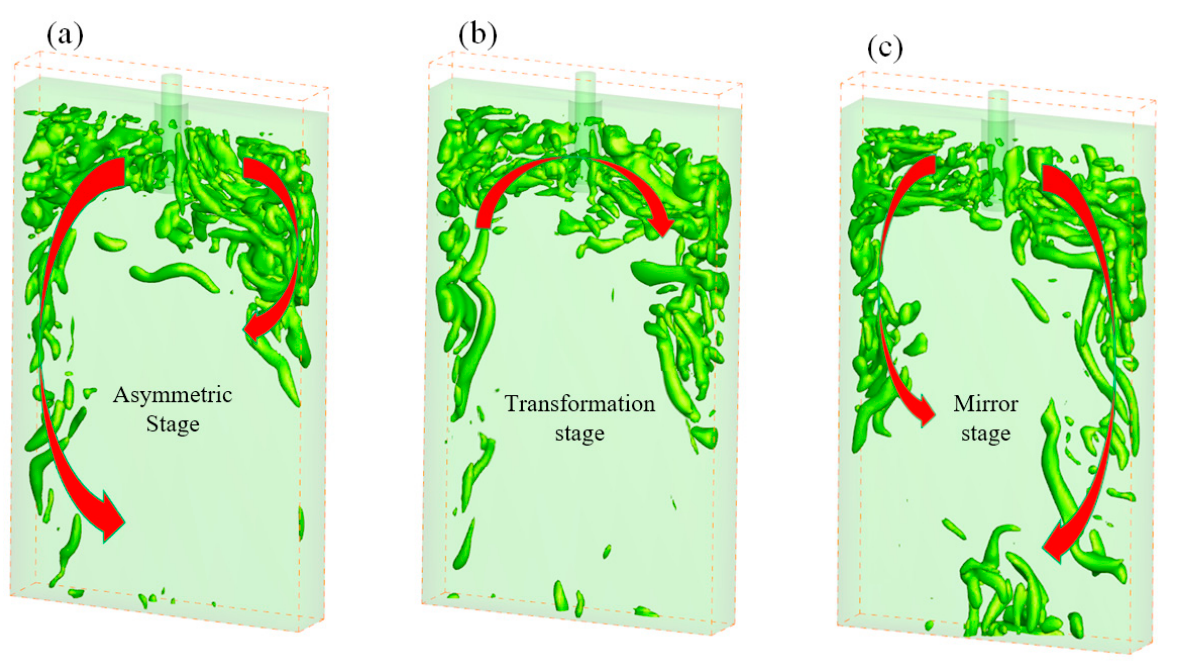
Figure 15. Asymmetric evolution of coherent structures near the narrow wall of the mold at the time of full development of turbulent flow at different stages: ( a ) asymmetry, ( b ) transformation, and ( c ) mirror image.